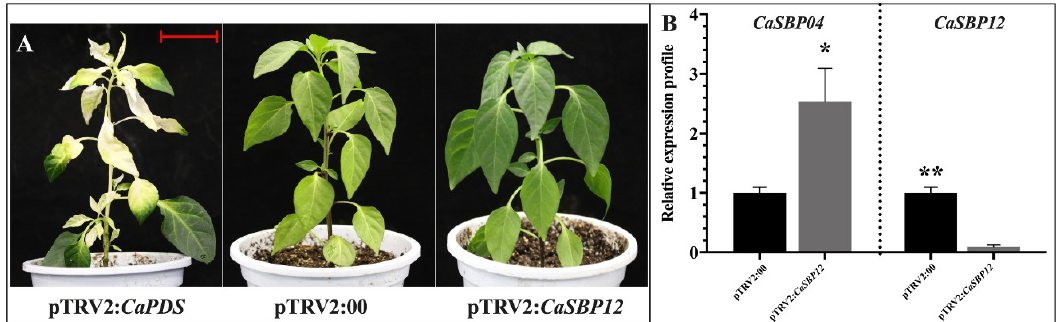
Figure 2. Phenotypes and silencing efficiency of CaSBP12 in silenced and control plants. ( A ) Phenotypes of CaPDS -silenced, CaSBP12 -silenced, and control plants. ( B ) Silencing efficiency of CaSBP12 and comparative expression of CaSBP04 (a highly homologous gene of CaSBP12 ) in the silenced and control plants. The red line used as a scale bar (length 3 cm). The means were analyzed using the least significant difference (LSD). * represents significant difference at p ≤ 0.05, and ** represents highly significant difference at p ≤ 0.01. Mean values and standard errors (SEs) for three replicates are